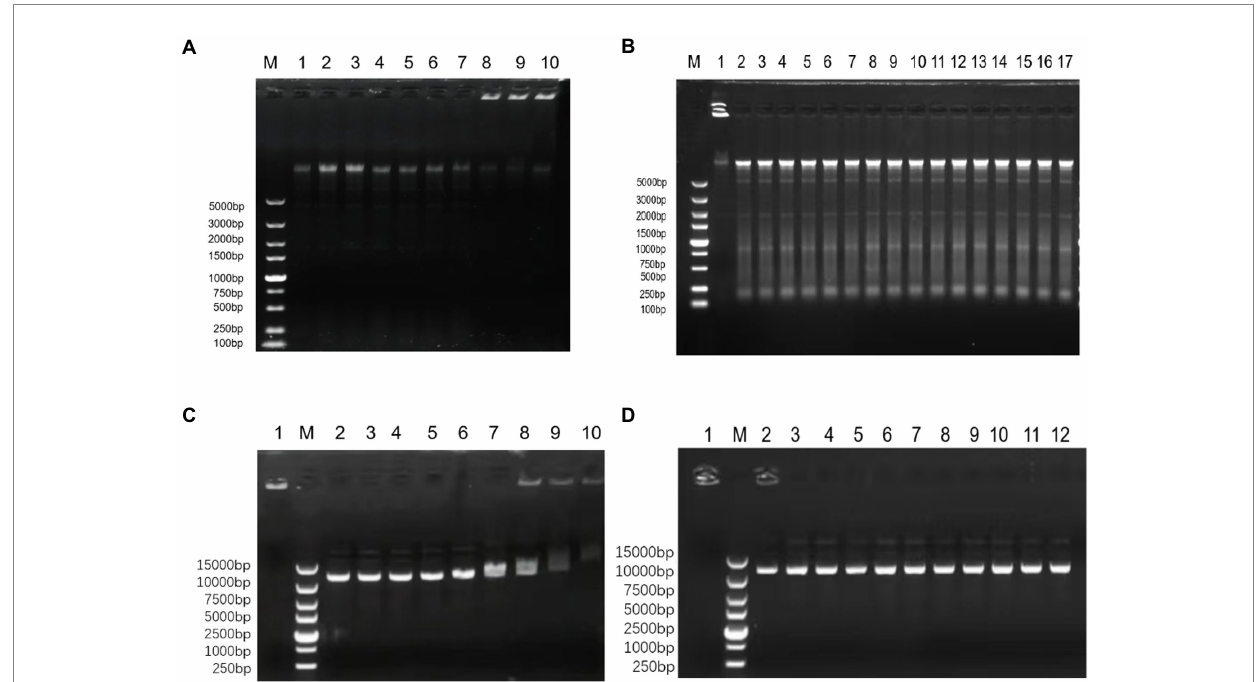
FIGURE 9 The effect of OM19r combined with GEN on the DNA of E. coli determined by DNA binding assay. (A) The effect of different concentrations of OM19r on the genomic DNA of E. coli B2, M: DL5000Marker; 1: E. coli B2 genome; 2: OM19r (2 μ g/ml); 3: OM19r (4 μ g/ml); 4: OM19r (8 μ g/ml); 5: OM19r (16 μ g/